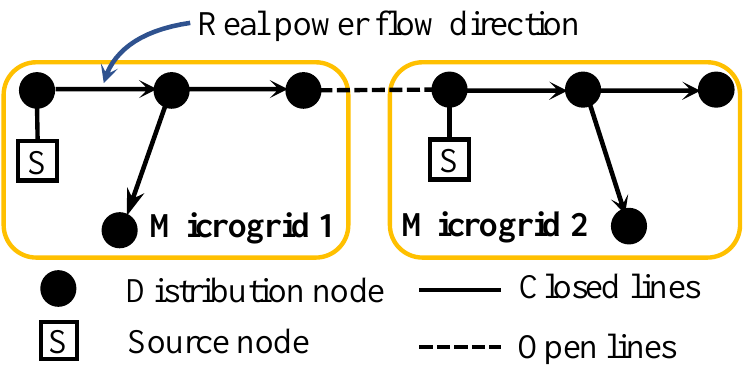
Figure 1. An illustration of the network